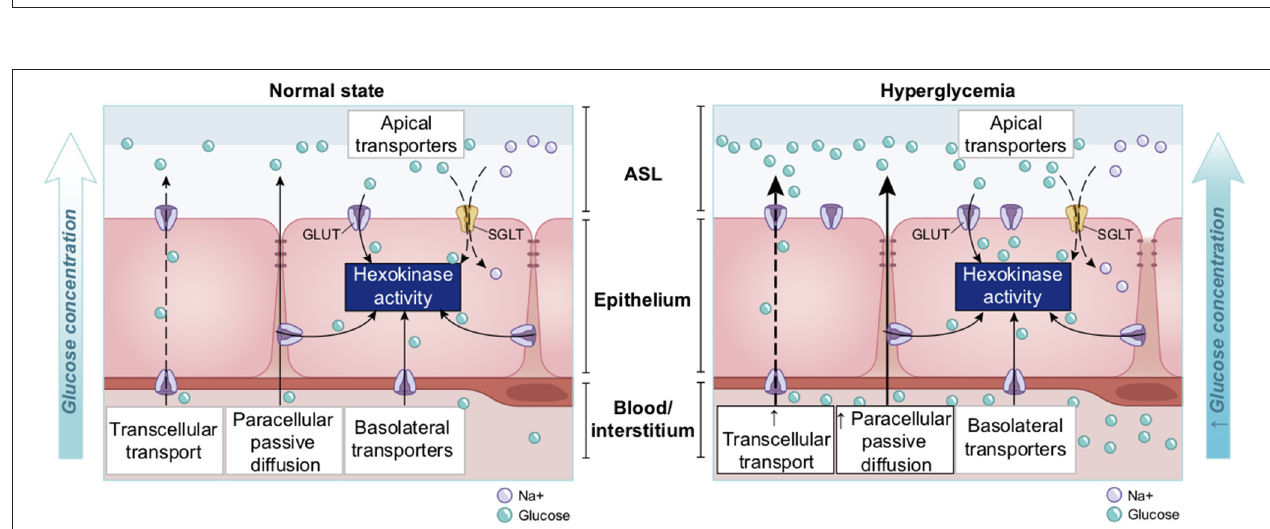
FIGURE 14 | Overview of glucose transport in the lung epithelial cells. In normal state, glucose is transcellularly transported from bloodstream into the ALS by specialized basolateral transporters GLUT, and is controlled by the intracellular hexokinase activity. Glucose is also transported by a passive paracellular diffusion. The latter is limited through tight junctions which link epithelial cells and maintain the tissue cohesion and integrity, rendering the paracellular diffusion extremely low. Reuptake of glucose from ASL occurs through apical GLUT or SGLT1 transporters. The overall glucose transfer results in ALS concentration of glucose 10–12 times lower than in blood. Conversely, in hyperglycemia where glucose concentration in the blood is higher (right panel), the glucose gradient is increased toward ASL leading to augmented transcellular transport. Additionally, defective tight junctions result in higher paracellular permeability. In such condition, the reuptake of glucose and rapid hexokinase metabolism of epithelial cells is then not sufficient to maintain a low concentration of glucose in the ASL, that could dramatically increase. GLUT, glucose transporter; SGLT, sodium-glucose linked transporter; Na + , sodium ion.